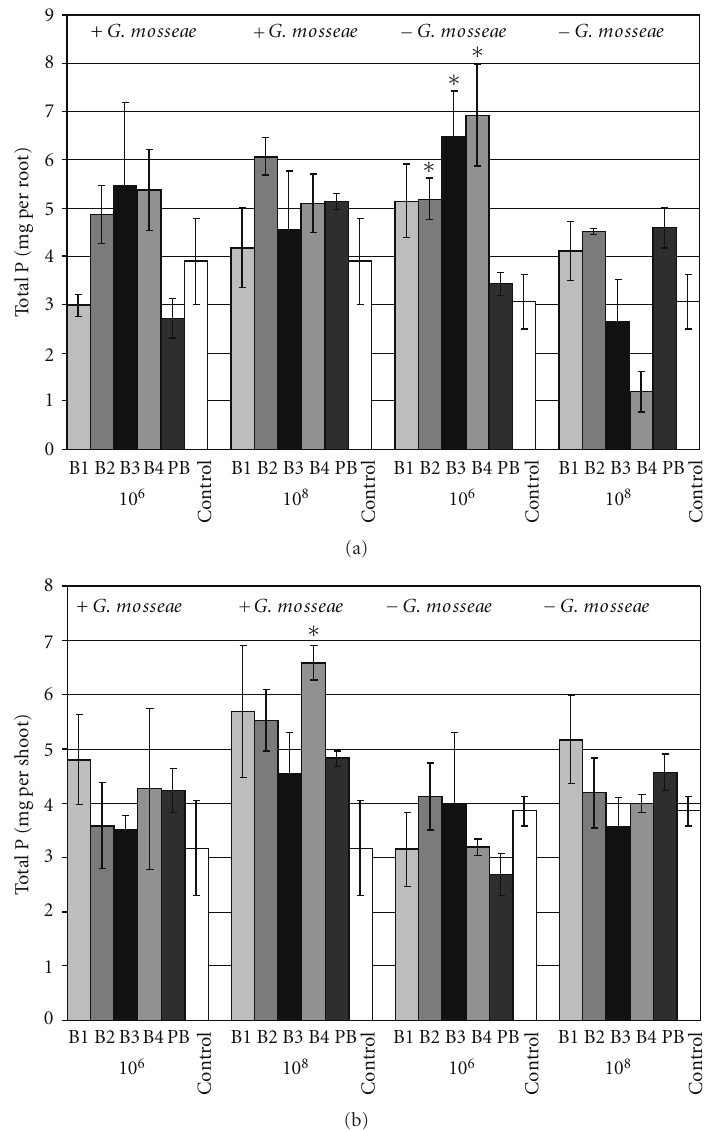
Figure 5: (a) Total phosphorus (milligram per plant) at harvest (15 weeks) in triplicate samples of wheat plant roots inoculated with or without G. mosseae or left untreated. Paenibacilli strains (B1–B4 and PB177) were added at a concentration of 10 6 or 10 8 bacterial cells 10g − 1 of seeds. Treatments that were significantly altered from control pots without added bacteria, as assessed with the unpaired t -test, are indicated as ∗ P < . 05. Error bars represent the standard error of the mean. (b) Total phosphorus (milligram per plant) at harvest (15 weeks) in triplicate samples of wheat plant shoots inoculated with or without G. mosseae or left untreated. Treatments and tests as in Figure